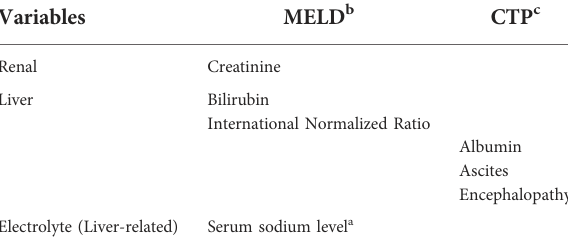
TABLE 1 Variables from model for end-stage liver disease (MELD) score and child-turcotte-pugh score for cirrhosis mortality (CTP)